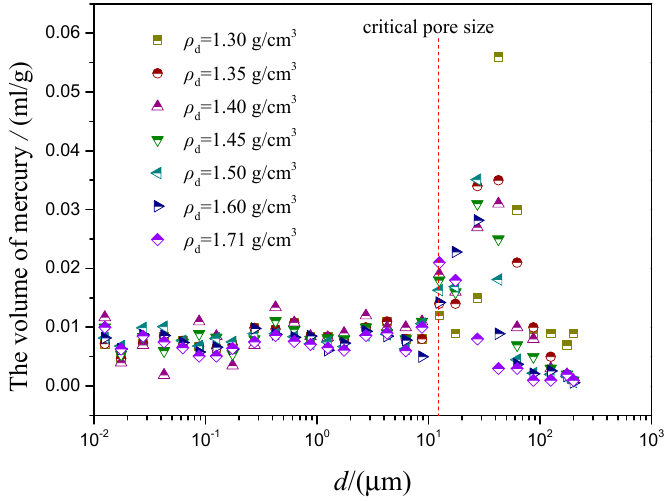
Figure 4. The experimental data of MIP tests